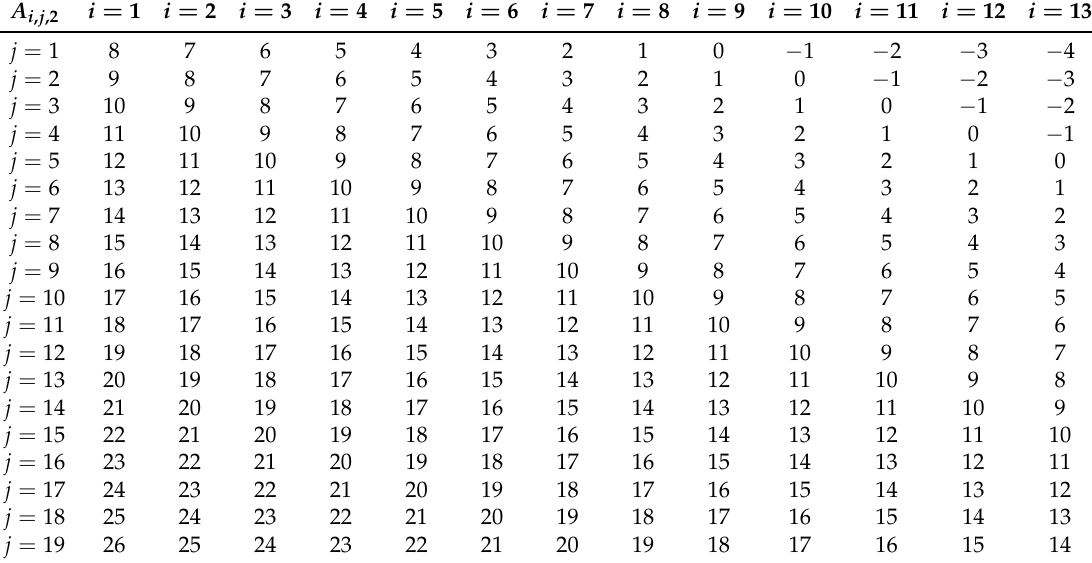
Table A3. Storage time of an assembly of LO1-2 belonging to the removal i ∈ I in the period j ∈ J A i , j ,2 . A i , j